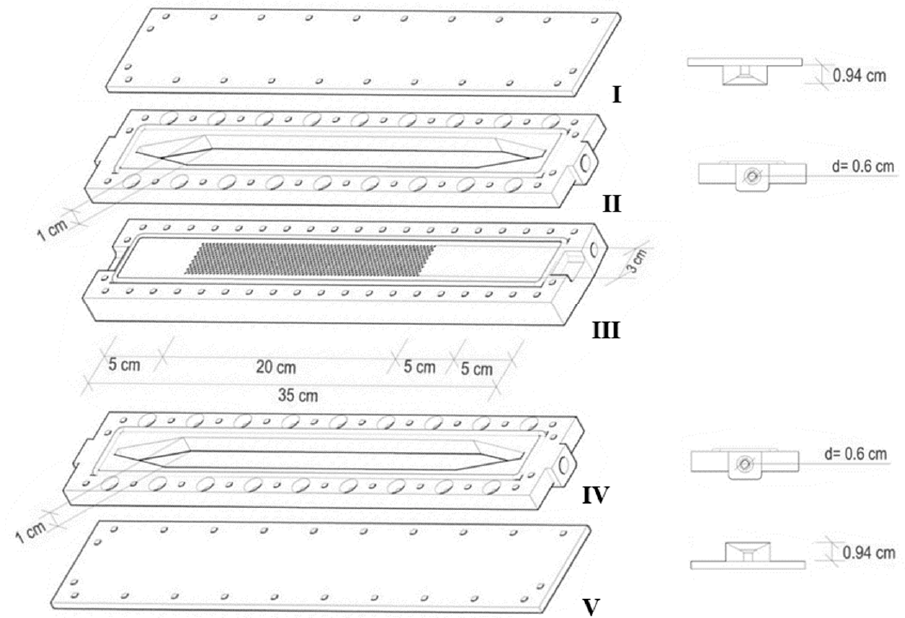
Figure 1. Schematic representation of the single hemodialysis membrane module. Unit I seals the feed flow chamber, represented by Unit II, while Unit V seals the permeate collecting chamber, represented by Unit IV. Unit III is the supporting surface for the membrane to be tested.